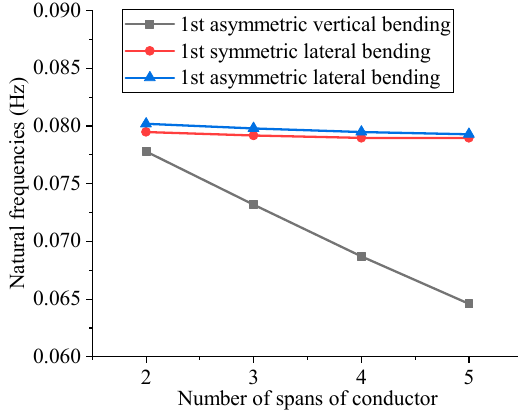
Figure 7. Frequencies of vibration modes of multi-span CRS.